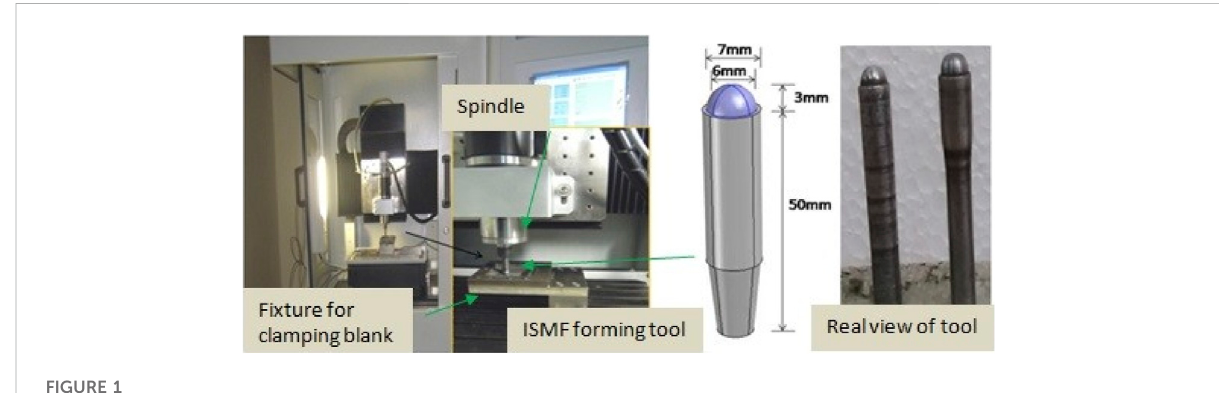
FIGURE 1 Experimental setup of SPIF and hemispherical end customized forming tool.